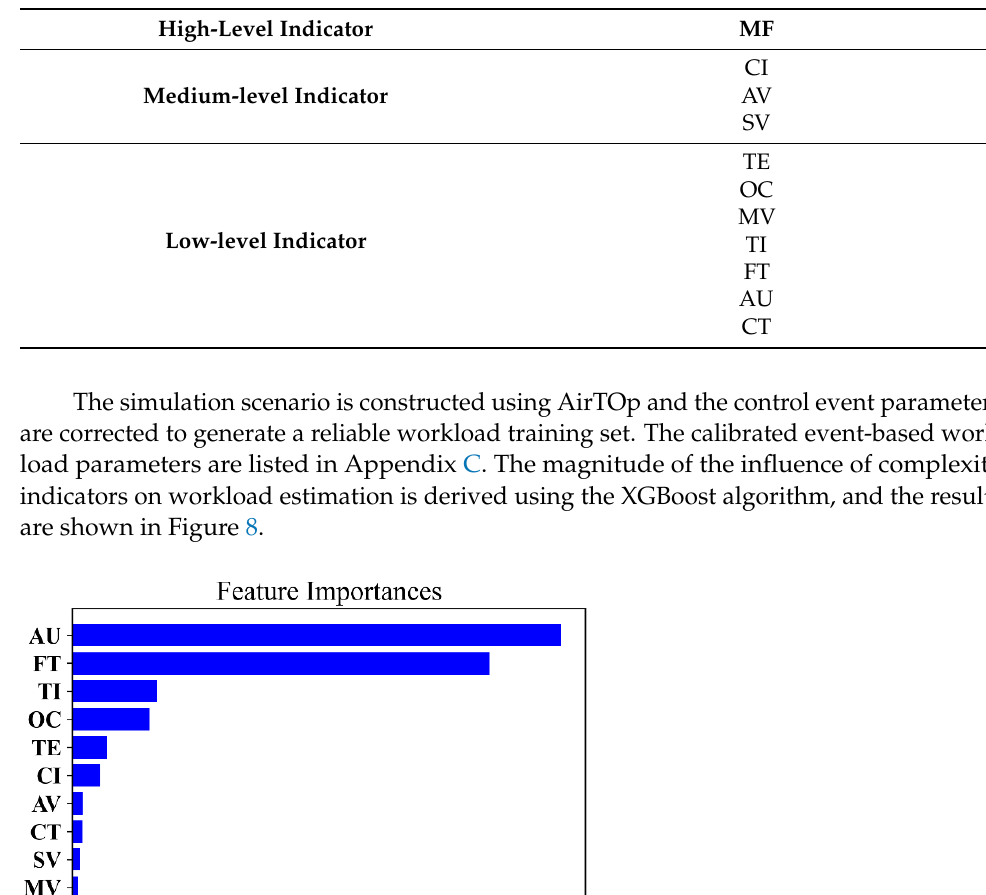
Table 3. Uncertainty classification of the complexity indicators.